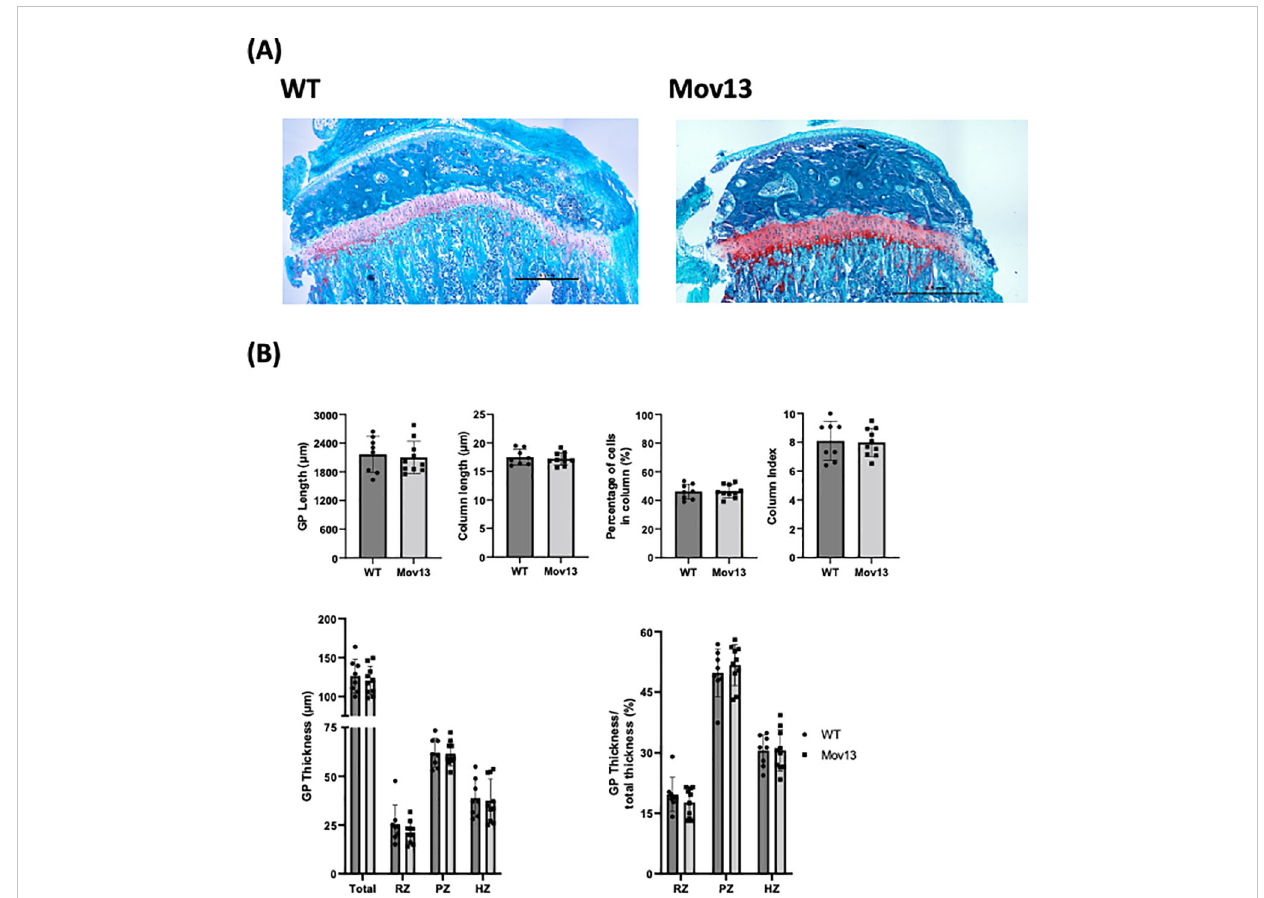
FIGURE 3 Histomorphometrical analysis of mouse growth plate. (A) Representative images of Safranin O staining of left tibia from eight-week-old Mov13 mice and WT littermates (10x10 magni fi cation). (B) GP length, column length, column index (CI), percentage of cells in column, thickness (total and the different zones; resting zone (RZ), proliferative zone (PZ) and hypertrophic zone (HZ)) and ratio of thickness. Values of standard deviation (SD) are shown for each group: WT (n=8, 40%male) and Mov13 (n=10, 50%male). Statistical signi fi cance is indicated on the graphs (P-values ≤ 0.05 (*)). GP thickness RZ and PZ were measured with a non-parametric unpaired